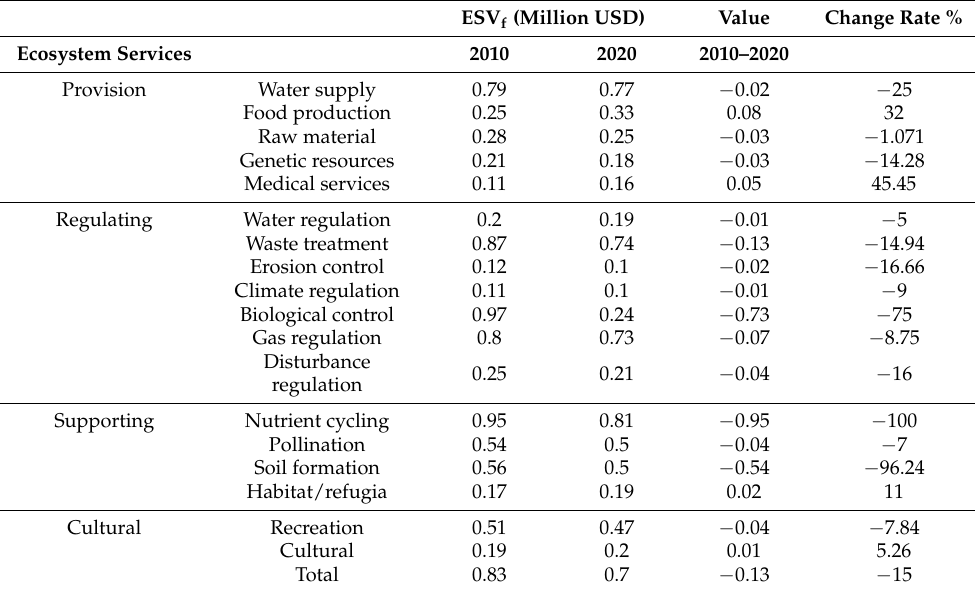
Table 8. Changes in ecosystem service function (USD million per